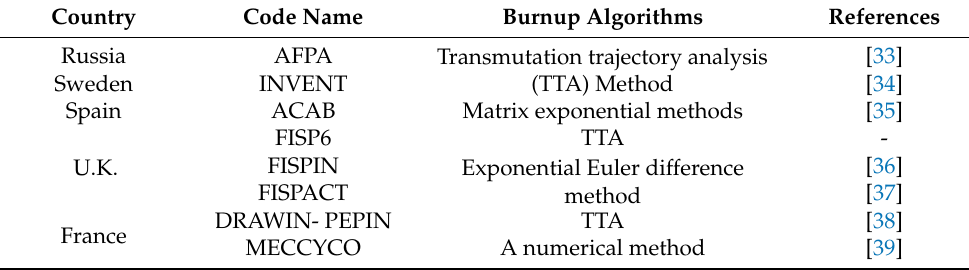
Table 1. Point depletion burnup computer codes for nuclide inventory